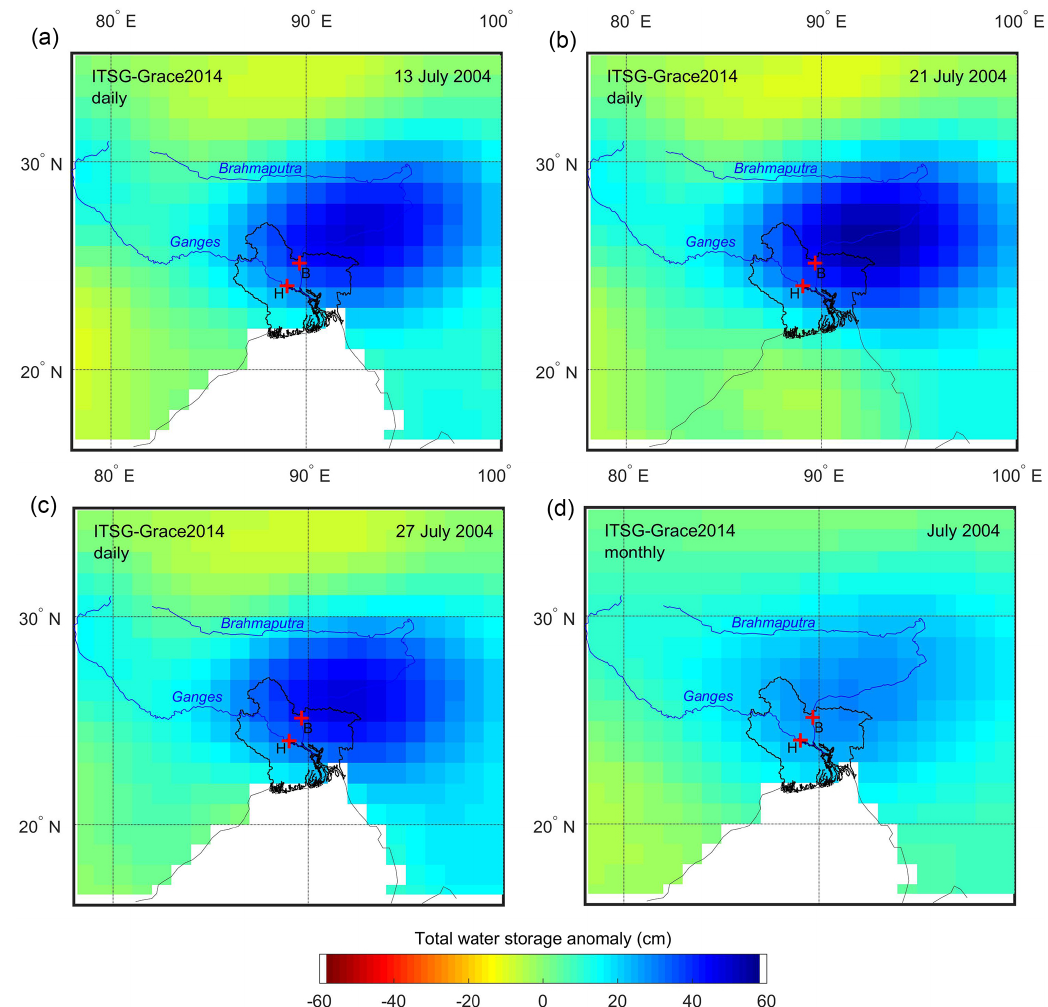
Figure 2. Daily and monthly water storage anomalies of the ITSG-Grace2014 solution for the Ganges–Brahmaputra Delta (outline indicated) on (a) 13 July 2004, (b) 21 July 2004, (c) 27 July 2004 and (d) July 2004. Increased TWSAs are related to flooding. River runoff stations are Bahadurabad (B) in the Brahmaputra and Hardinge Bridge (H) in the